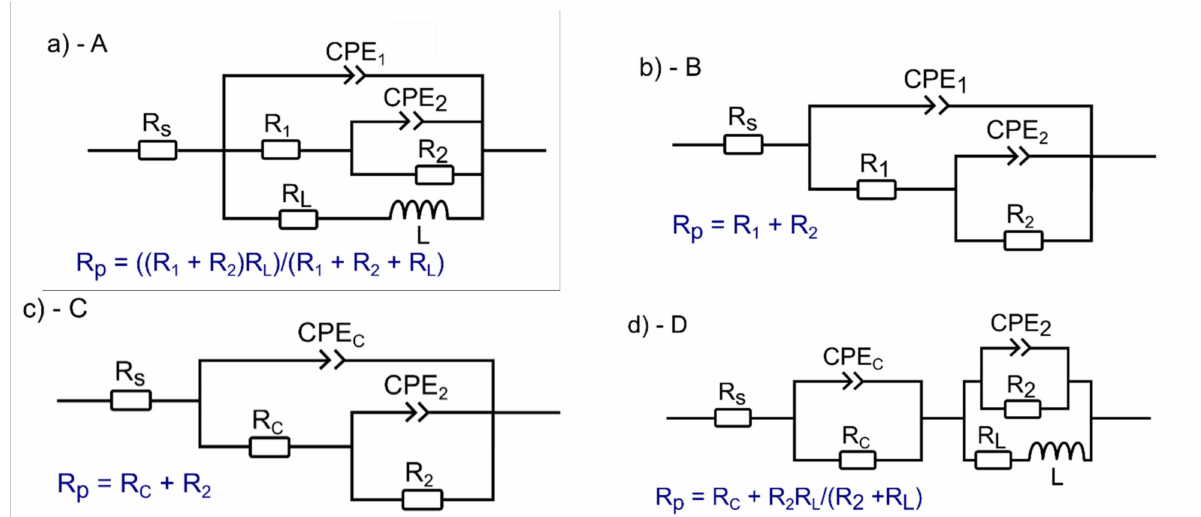
Figure 7. Equivalent circuits used to the evaluation of the Nyquist plots with R p